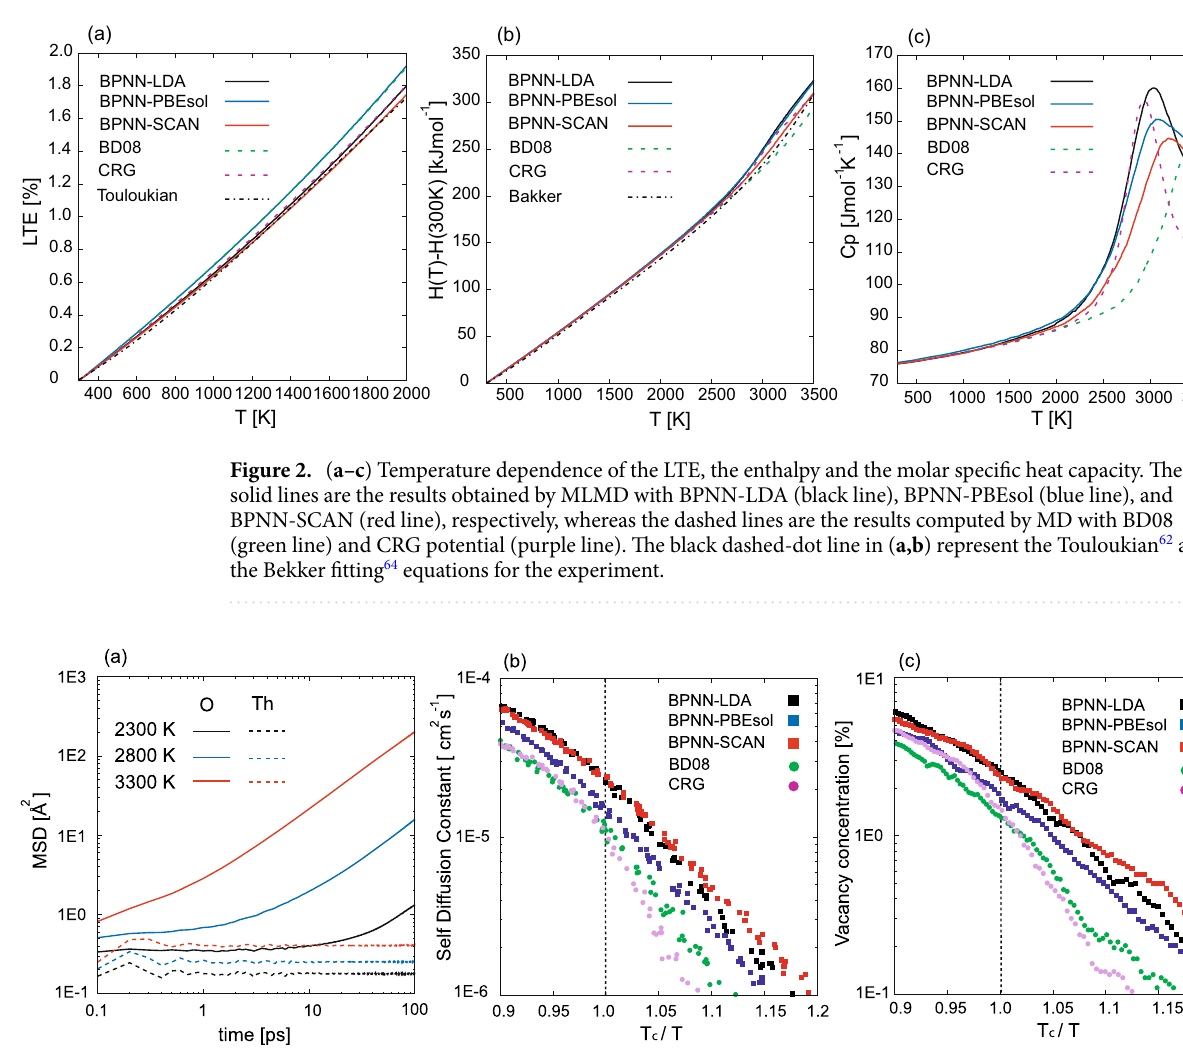
Figure 3. ( a ) MSD obtained by MLMD with BPNN-SCAN. ( b ) Temperature dependence of the self-diffusion constant for oxygen. ( c ) Temperature dependence of the vacancy